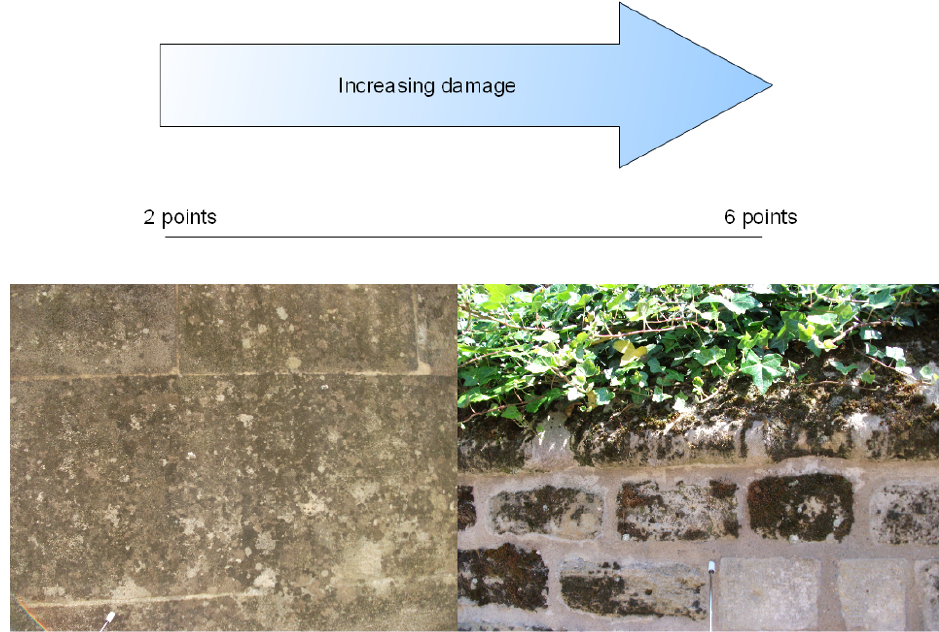
Figure 2. Range of scores in this tiered five-point limestone weathering